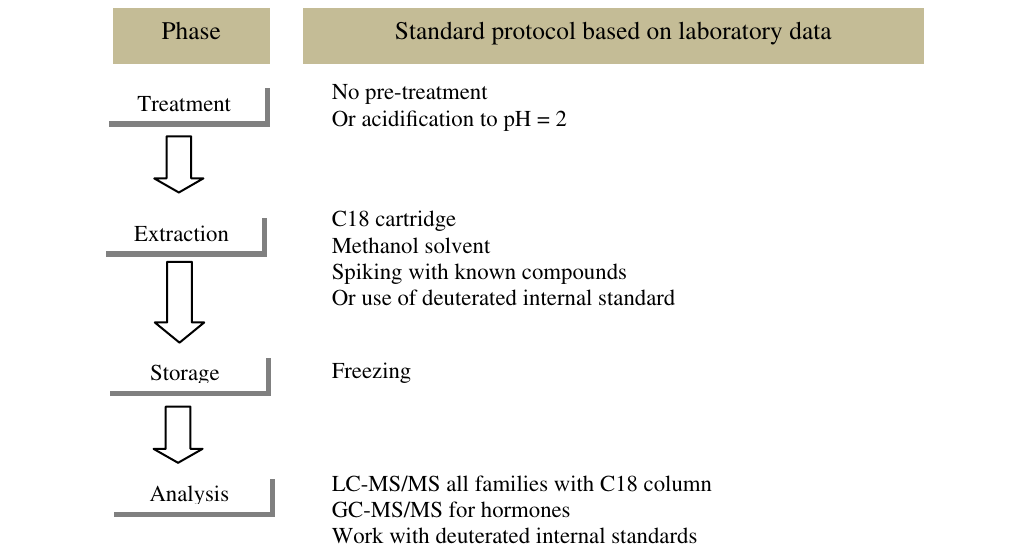
Fig. 3. Standard diagram of analytical phases on the basis of the information supplied by the